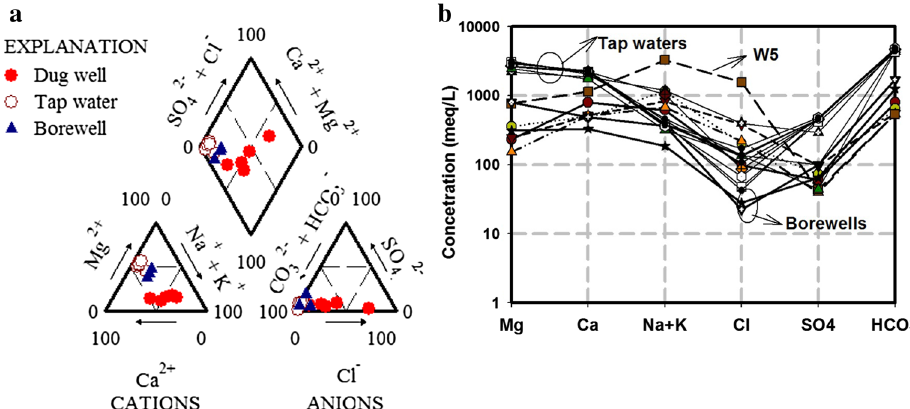
Fig. 8 a Piper diagram display- ing the dominant water types of the groundwaters; b Schöeller diagram showing major ion distribution patterns of the groundwaters. Tap waters are enriched in Mg 2+ and Ca 2+ , while dug well waters tend to have high Na + and K + content. Bicarbonate is the dominant anion in the